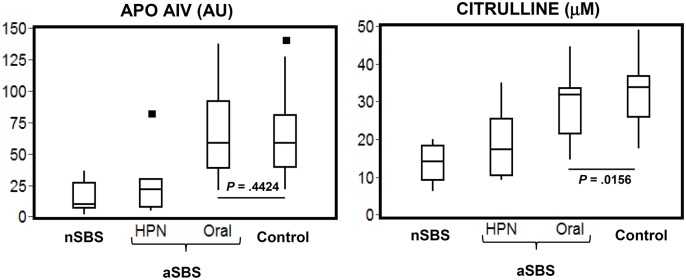
Box plots for plasma concentrations of Apo AIV and citrulline in selected SBS patients and healthy subjects.SBS groups: non-adapted nSBS (n = 8), adapted SBS HPN group (n = 7), and adapted SBS ORAL group (n = 19). Healthy subjects -Control group (n = 39). Outliers shown as black squares. P< .05 between aSBS ORAL and Control groups.